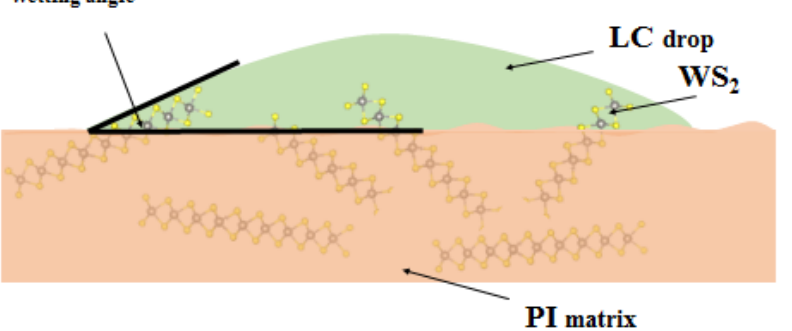
Figure 5. Schematic illustration of the WS 2 NTs protruding from the PI matrix and their influence on the surface texture and the LC drop orientation.